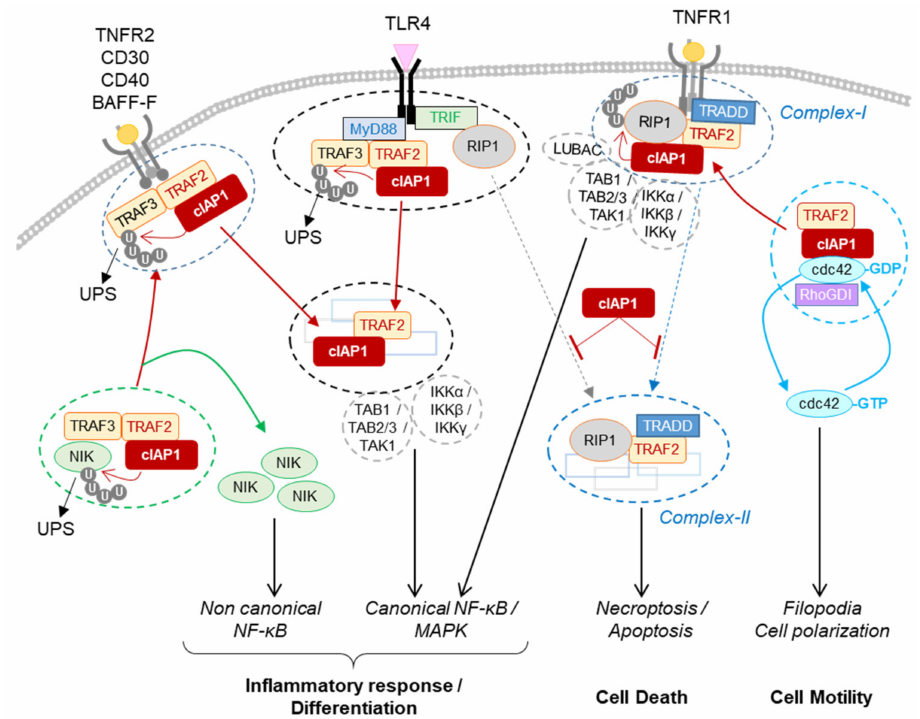
Figure 4. Regulation of signaling pathways by cIAP1. The cIAP1-TRAF2 E3-Ubiquitin ligase complex regulates the cellular content of NIK by mediating its ubiquitin-proteasome dependent degradation. The recruitment of cIAP1/TRAF2 to TNFR2, CD30, CD40 or BAFF-R releases NIK that in turn stimulates the non-canonical NF- κ B signaling pathway. In the TLR4-associated signaling complex, cIAP1 induces the ubiquitination and degradation of TRAF3. cIAP1/TRAF2 forms a secondary cytoplasmic complex leading to NF-kB / MAPK activation. In TNFR1-associated complex, cIAP1 induces the ubiquitination of RIP1 and other components of the complex, resulting in the assembly of the signaling platform driving NF- κ B and MAPK activation. cIAP1-mediated ubiquitination of RIP1 inhibits its kinase activity required for the assembly of cytoplasmic RIP-containing platforms leading to apoptotic or necrotic cell death. cIAP1 controls the cycle of activation of cdc42. The recruitment of cIAP1/TRAF2 to TNFR-associated signaling complex releases cdc42 for